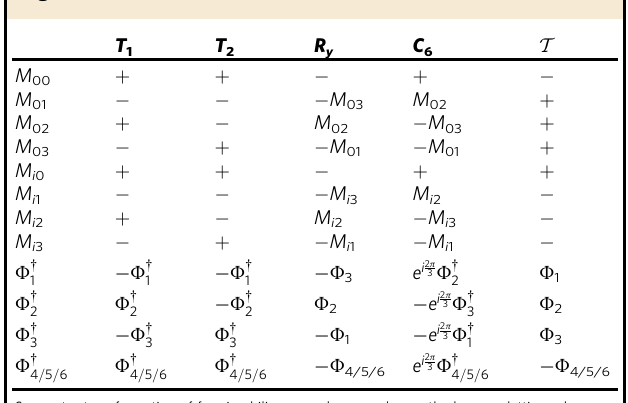
Table 3 Fermion bilinear and monopole symmetries on the kagome